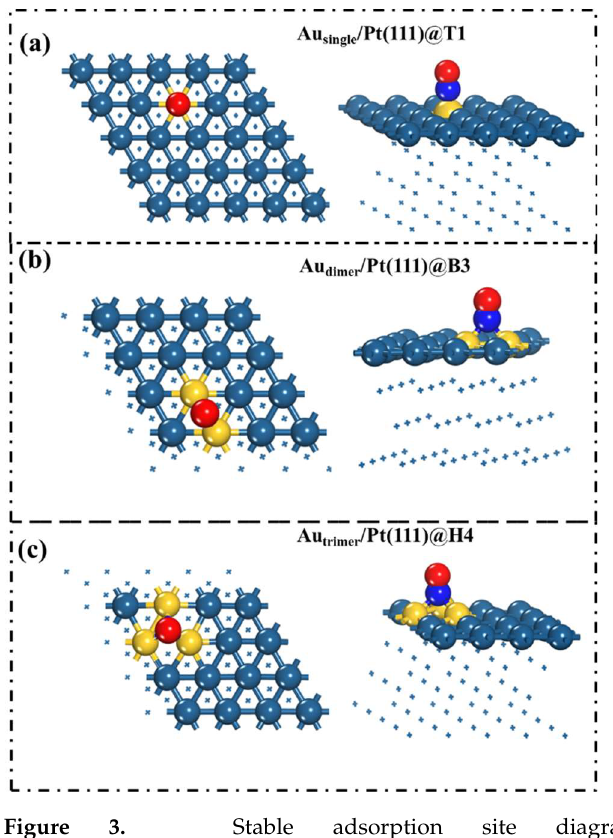
Figure 3. Stable adsorption site diagrams on ( a ) Au single /Pt(111), ( b ) Au dimer /Pt(111), and ( c ) Au trimer /Pt(111) surfaces. Red represents O atoms, blue represents N atoms.